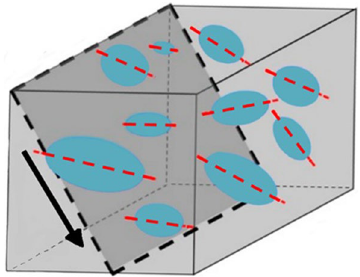
Figure 5. A representative figure to show slope and slope direction as described in the manuscript. The grey cube represents a sediment matrix, and the blue ovals represent individual clasts ‘floating’ within. The plane outlined by the dashed lines is the incline and the black arrow shows the slope direction and amount. Red dashed lines represent the steepest angle, or ‘slope direction’ of the clasts relative to a horizontal plane—herein 20° to 70° east.